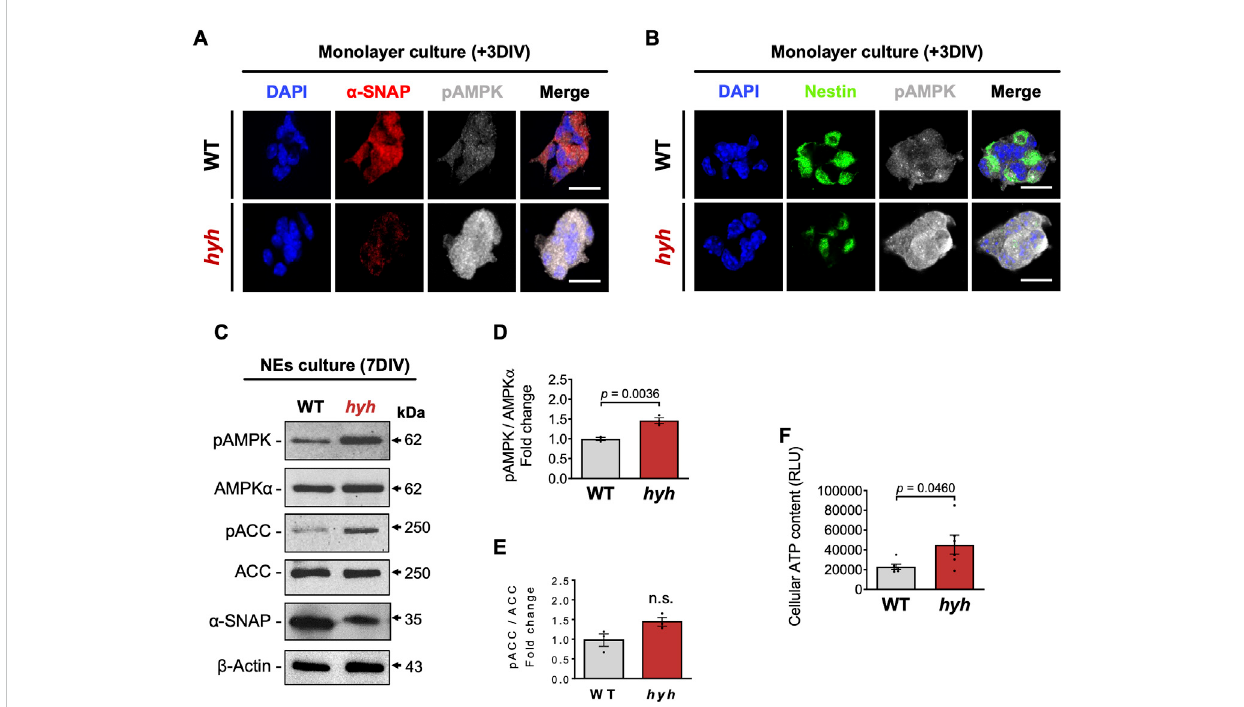
FIGURE 6 AMPK overactivation in NSPCs derived from hyh mice. (A,B) . Neurospheres (7DIV) were disaggregated and cultured as monolayer for 3DIV. Representative double immuno fl uorescence stainings of pAMPK combined with α -SNAP (A) and Nestin (B) . Scale Bars: D-E = 20 µm. (C) . Western blot analysis of seven DIV neurospheres obtained from WT and hyh mice using antibodies against α -SNAP, pAMPK, AMPK α , pACC and ACC. (D,E) . DensitometricanalysisofpAMPK (D) andpACC (E) proteinlevelsnormalizedonAMPKandACCtotalproteinlevels,respectively. (F) .Measurementof cellular ATP content of seven DIV neurospheres. RLU: relative luminescence units. The bars represent mean ± SEM (n = 3 in D-E; n = 6 in F). Differences with p < 0.05 were considered signi fi cant (Student ’ s t-test with Welch ’ s correction). n. s. = no signi fi cant